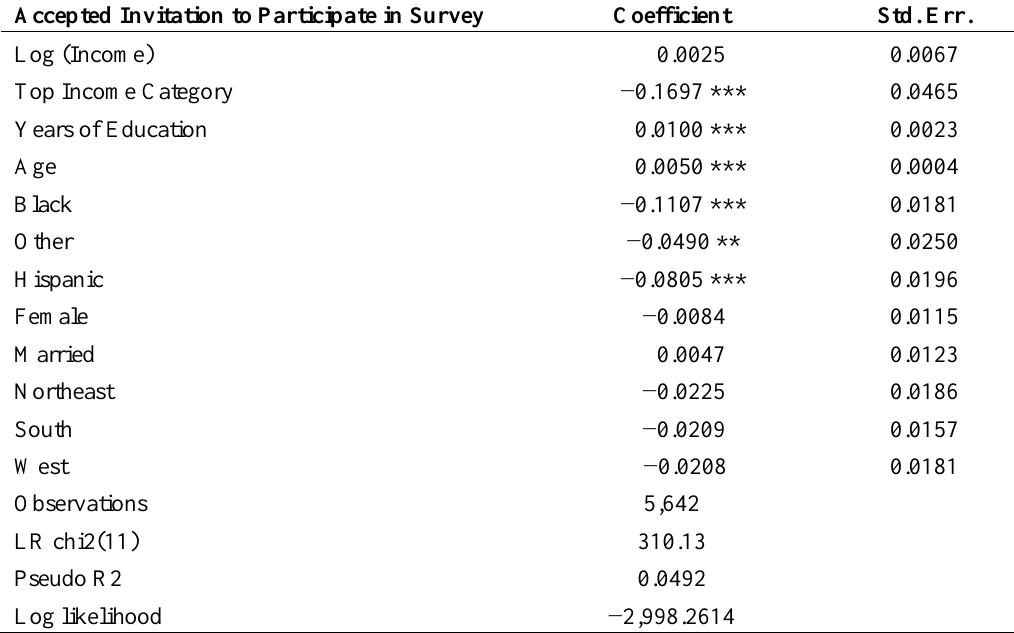
Table 8. Probit regressions predicting non-response in Internet panel a